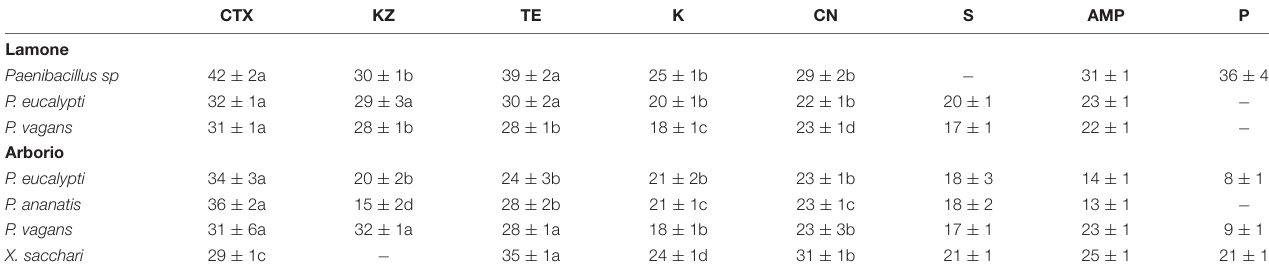
TABLE 4 | Antimicrobial susceptibility test applying in vitro diffusion on bacteria isolated from rice samples under submergence and showing PGP activities under hypoxia from Table 3